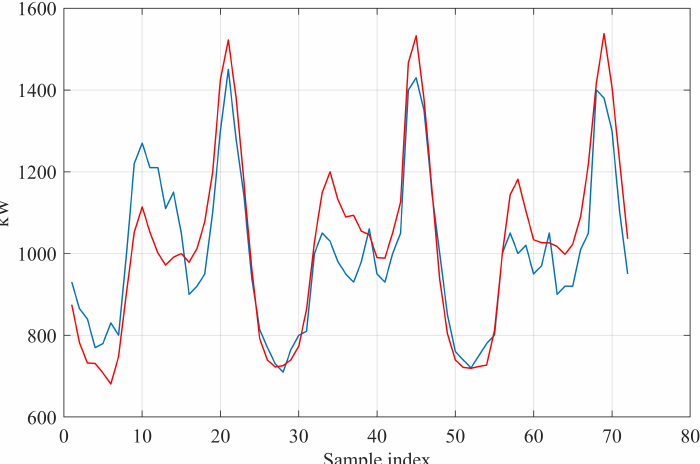
Figure 28. Actual (blue) and predicted (red) load in the middle of May 2016. Adapted with permission from [41], © 2018 IEEE.